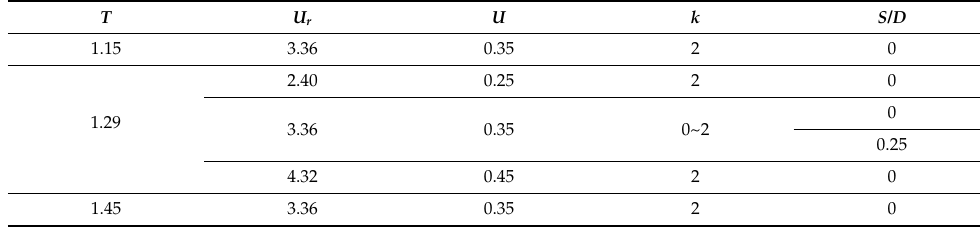
Table 2. Relevant parameters of the working condition.